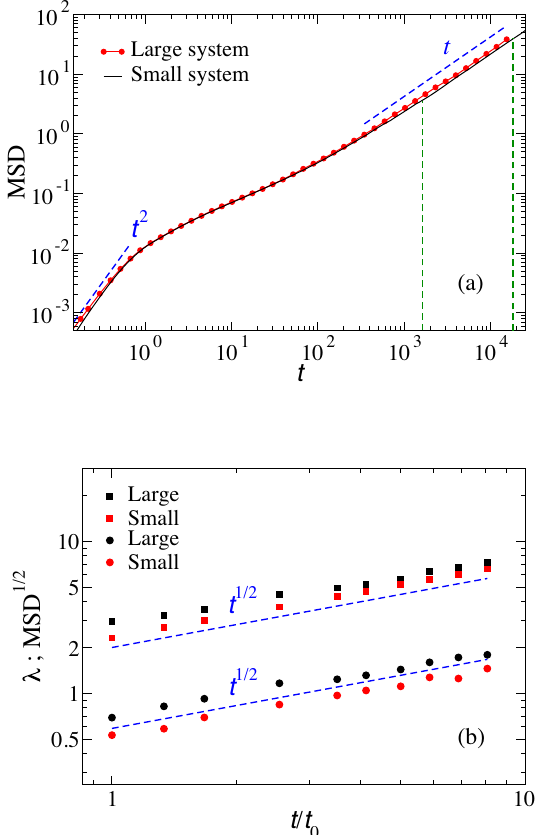
FIG. 7. MSD and Brownian yet non-Gaussian regime for two 2D Kob-Andersen binary mixtures of different size. (a) Double-log plot of the MSD at T ¼ 0 . 6 for the large and small system, covering the whole time regime from ballistic to diffusive motion. We mark by vertical dashed lines the time window corresponding to the analyzed Brow- nian yet non-Gaussian regime. (b) Double-log plot of MSD 1 = 2 (squares) and λ (circles) as a function of time for the large and small system at T ¼ 0 . 6 . Here, t 0 is the temperature- dependent time at which the systems reach a μ value compatible with 1 within numerical uncertainty, i.e., MSD ( t ≥ t 0 ) ∼ t μ ≅ 1 (see Sec. VI). The analyzed time window corresponds to the time regime signaled by vertical dashed lines in (a). Dashed lines representing power-law behaviors in (a) and (b) serve as a